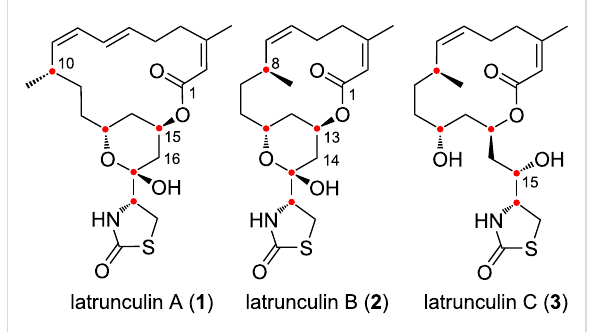
Figure 1: Structure of latrunculins (the red dots show the natural prod- uct stereopentade).